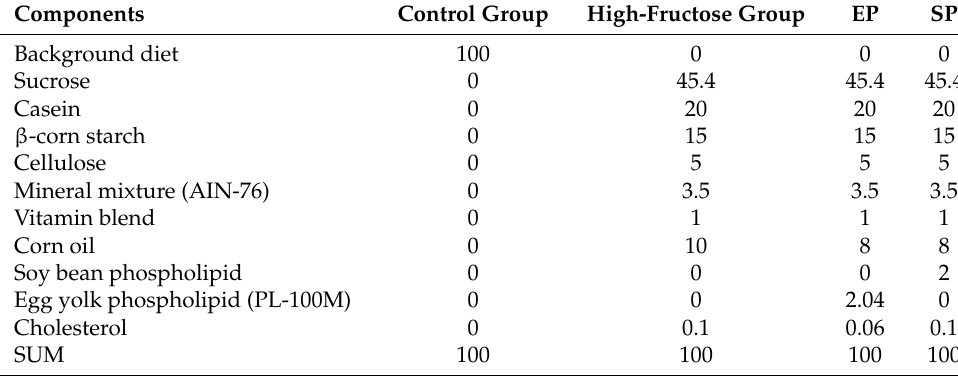
Table 1. Composition and mass percentage of experimental diets (%).